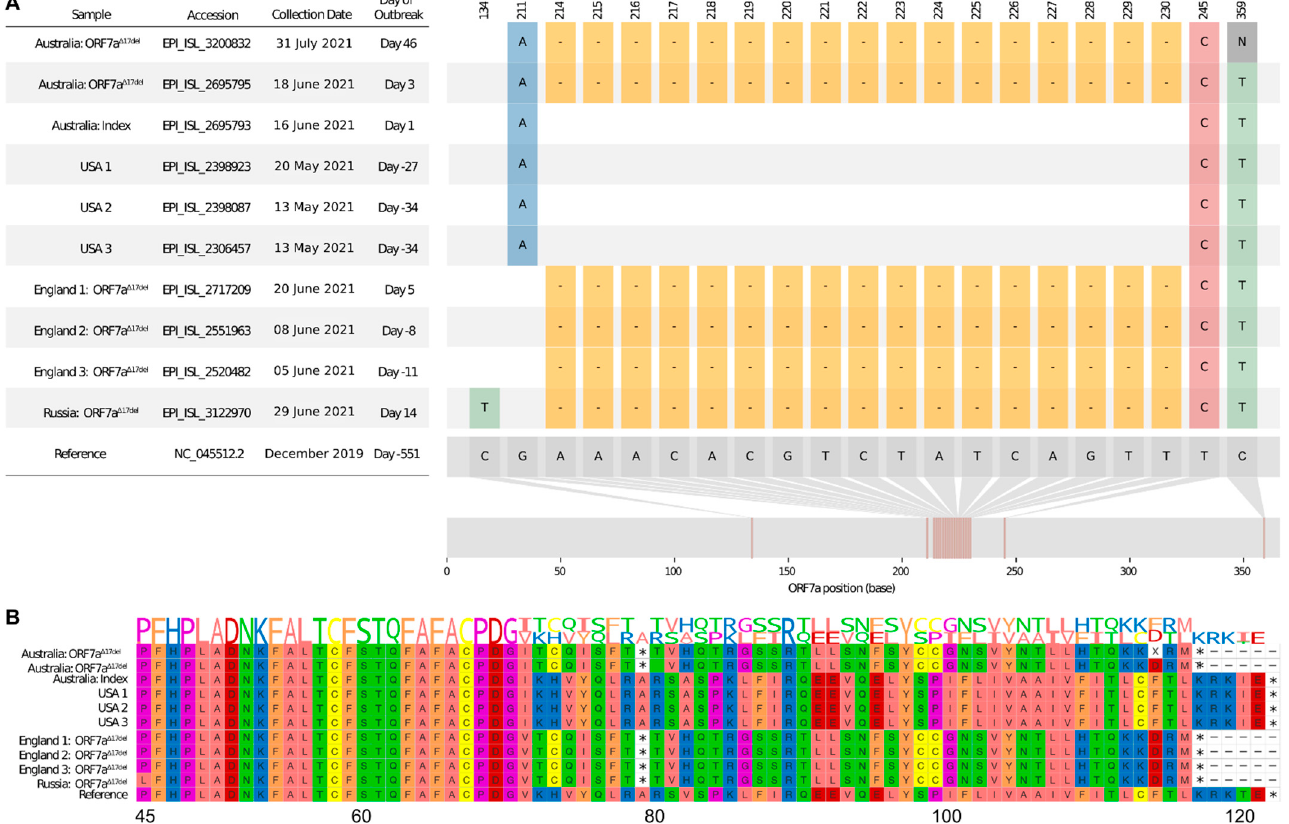
Figure 1. Visualisation of a 17-nucleotide deletion in ORF7a of Delta variant SARS-CoV-2 sequences (ORF7a ∆ 17del ) and the corresponding consequences at the peptide level. Sequences chosen for visualisation include an index case of the Australian Delta outbreak (lacking ORF7a Δ 17del ), the first